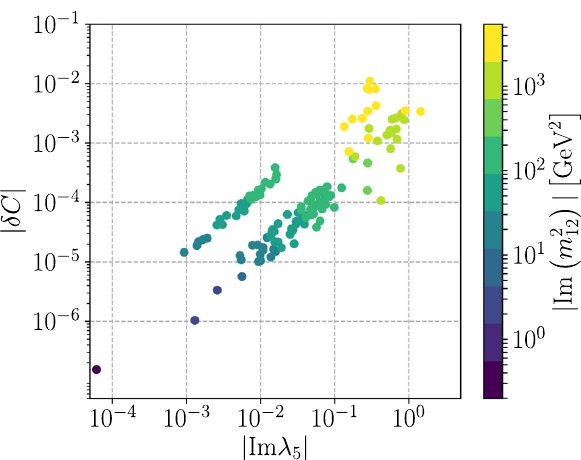
Table 3 Parameter ranges for the C2HDM TII input parameters used in ScannerS